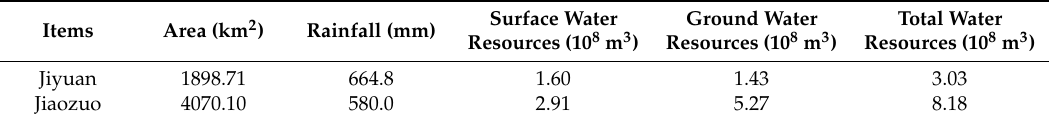
Table 2. Basic situation of water resources in the study